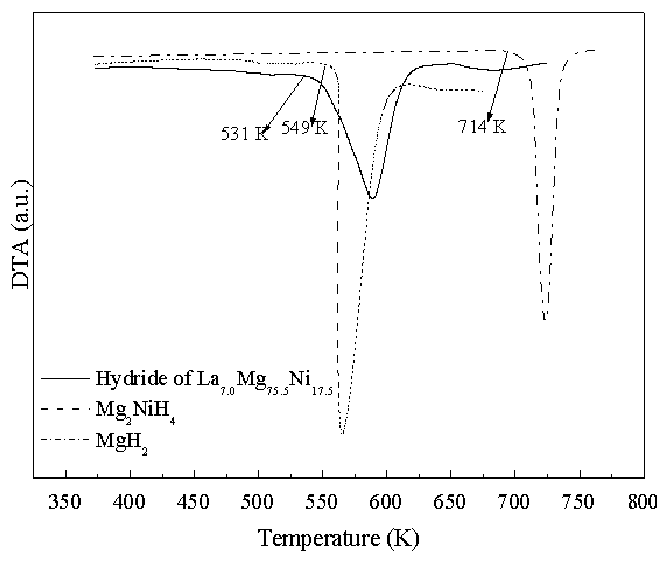
Figure 8. DTA curves of MgH 2 , Mg 2 NiH 4 , and hydride of the La7.0Mg 755 Ni 17.5 alloy.